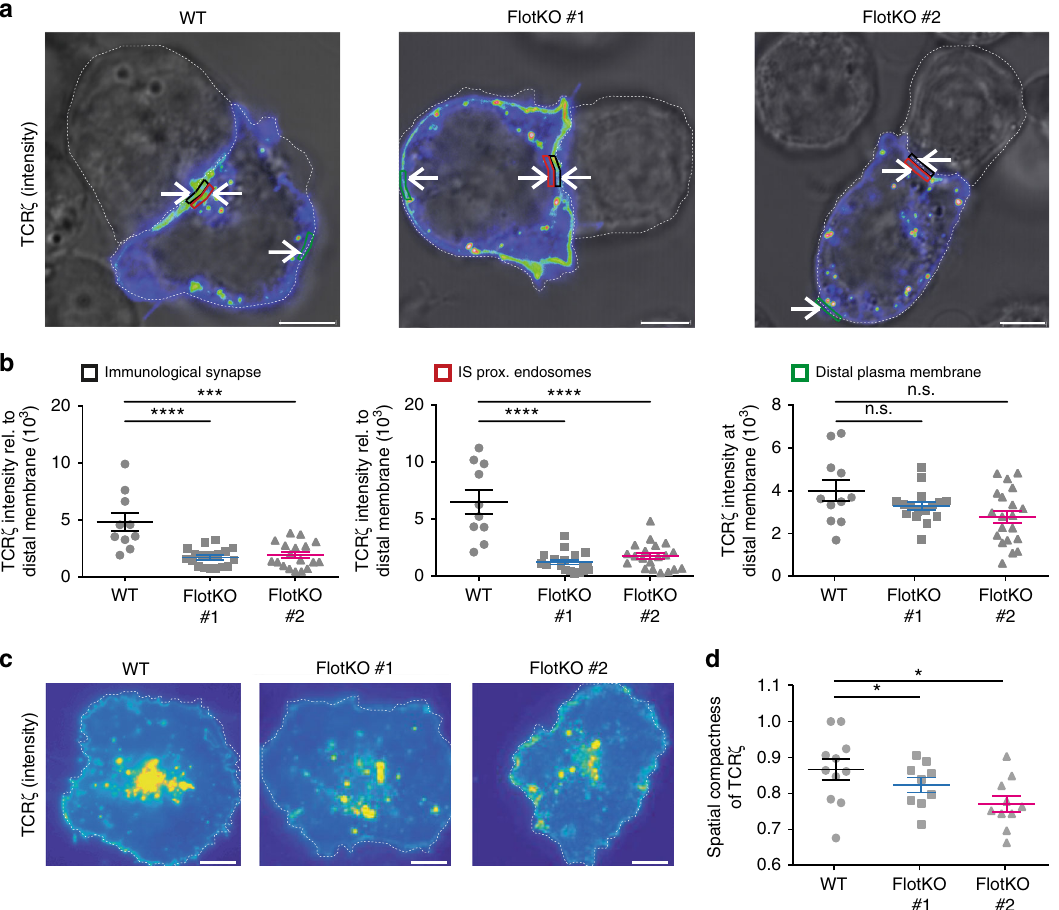
Fig. 5 Flotillins organize the subcellular localization of TCR ζ . a Representative images of wildtype and Flotillin1/2 KO Jurkat T cells expressing TCR ζ - mCherry and conjugated to SEE pulsed Raji B cells. b TCR ζ -mCherry intensity at the immunological synapse, a region directly behind the synapse, and at a region in the plasma membrane distal to the immunological synapse. Regions are indicated by corresponding colored boxes in a (arrows). c Representative TIRF images of wildtype and Flotillin1/2 KO Jurkat T cells expressing TCR ζ -mCherry on activating anti-CD3 ε and anti-CD28 antibodies coated glass surfaces. d Quanti fi cation of the 2D spatial distribution of TCR ζ -mCherry intensity. A score of 1 means that the total mCherry intensity detected in the image is concentrated within one single pixel. Scale bars, 5 µ m. Data obtained from three independent experiments. Error bars indicate mean (±SEM). ns, not signi fi cant; * p < 0.01; *** p < 0.0001; **** p < 0.00001; Mann – Whitney t